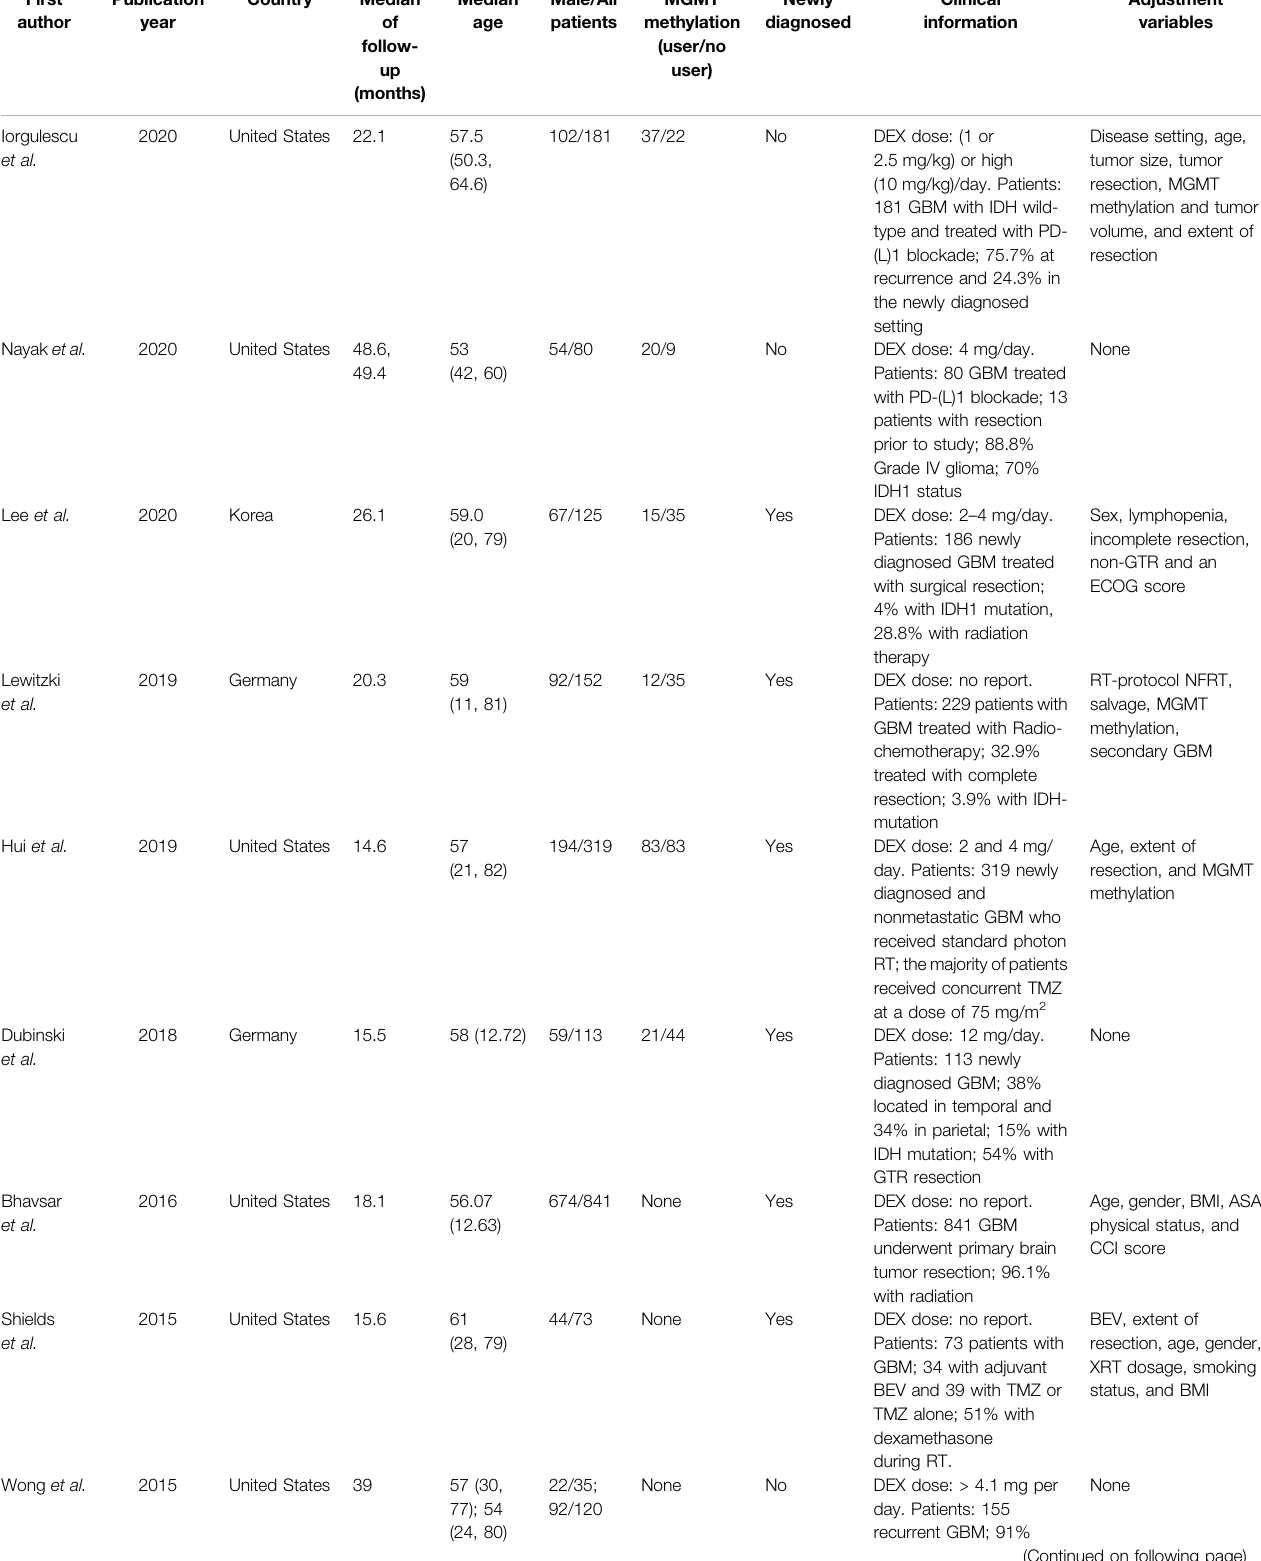
TABLE 1 | The main characteristics of included